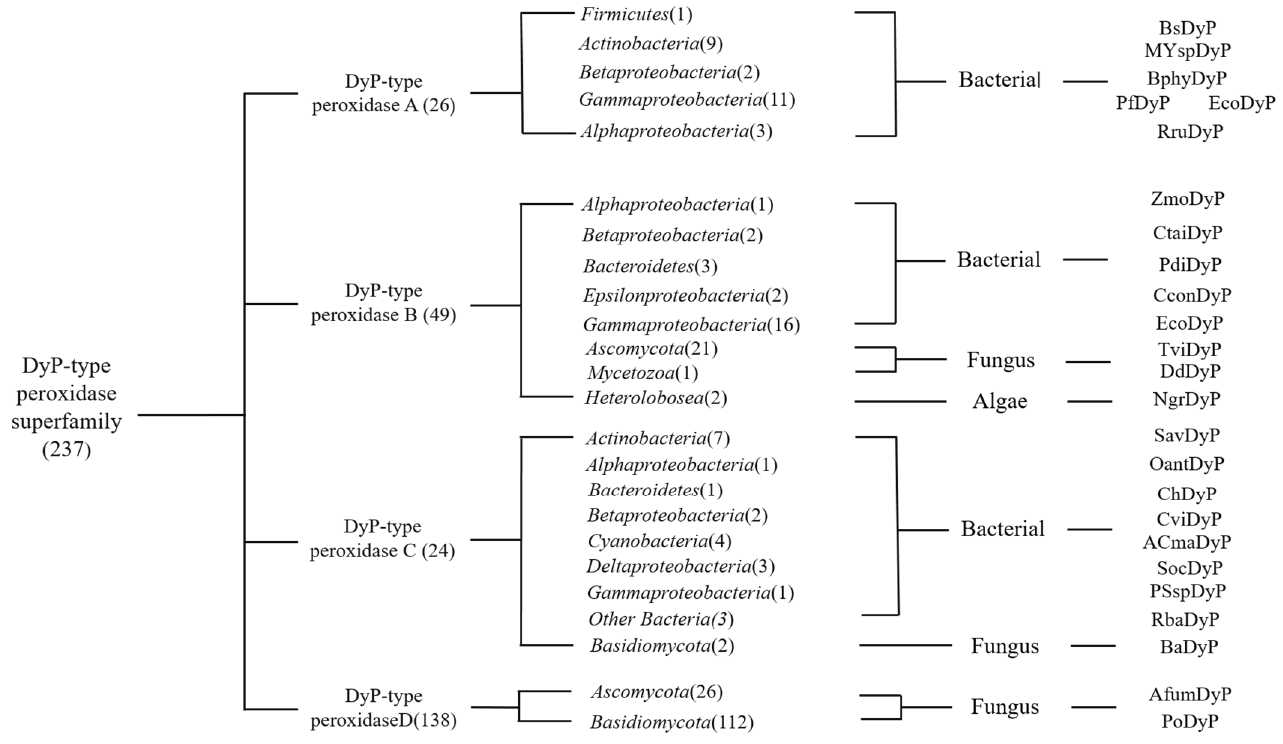
Figure 1. Phylogenic graph details the DyPs classes in the database and the corresponding producing microorganisms.